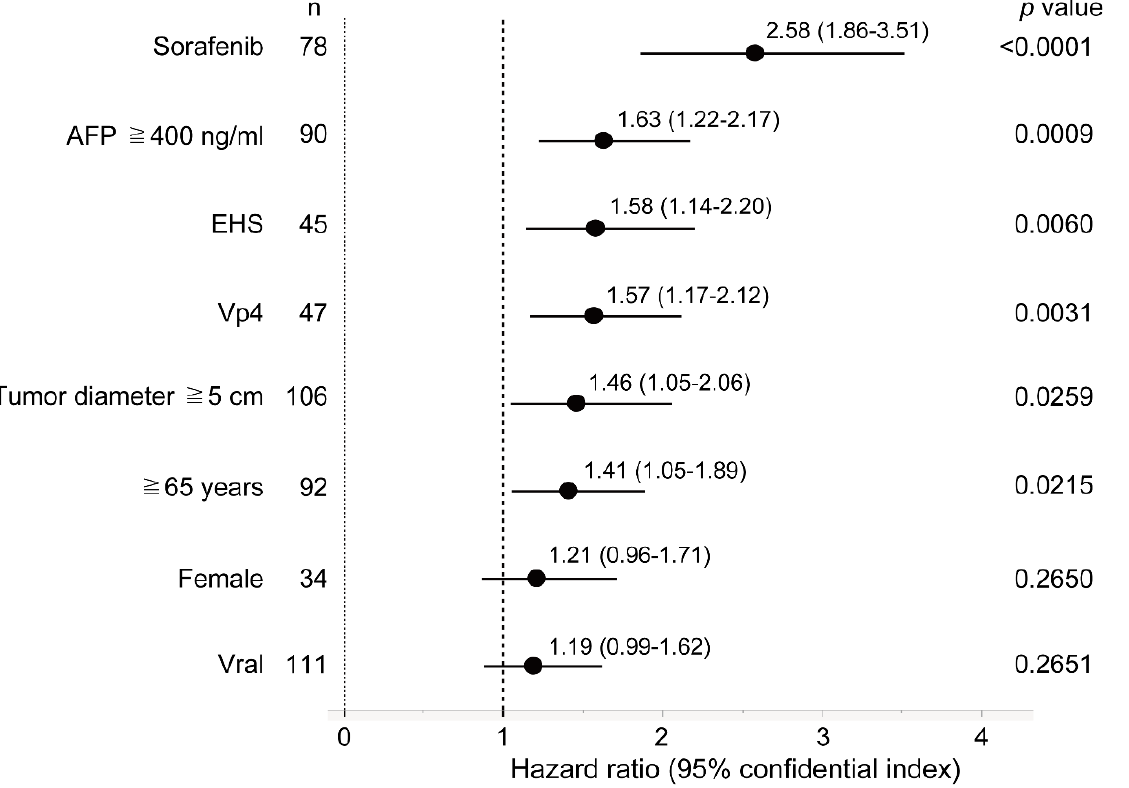
Figure 4. Forest plot analysis for factors associated with poor prognosis in patients with major PVTT-HCC. AFP, alpha-fetoprotein; EHS, extrahepatic spread; HCC, hepatocellular carcinoma; Vp4, tumor invasion into the trunk of the portal vein; PVTT, portal vein tumor thrombus.